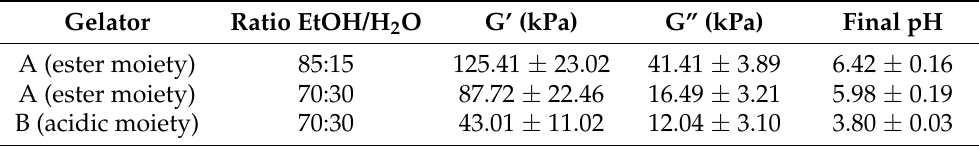
Table 3. Summary of the gel properties (G’ and G” were taken from amplitude sweep at shear strain 0.03%).